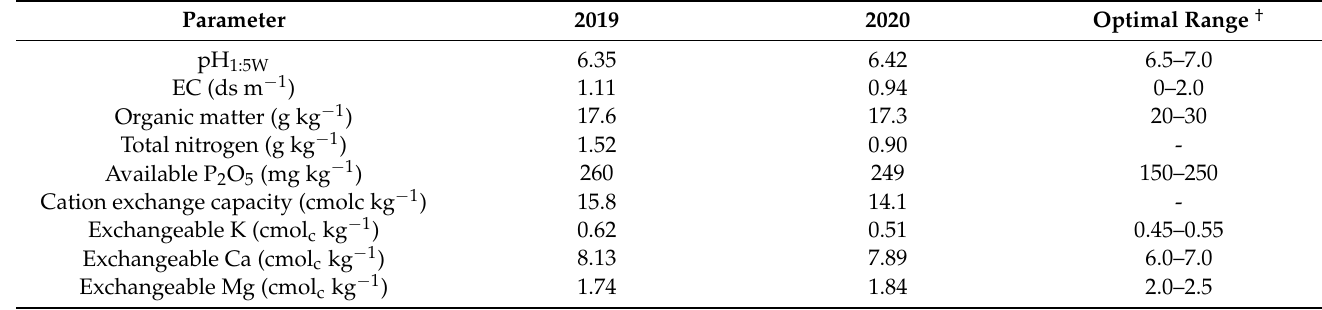
Table 1. Initial soil properties of this experiment in 2019 and 2020 year.